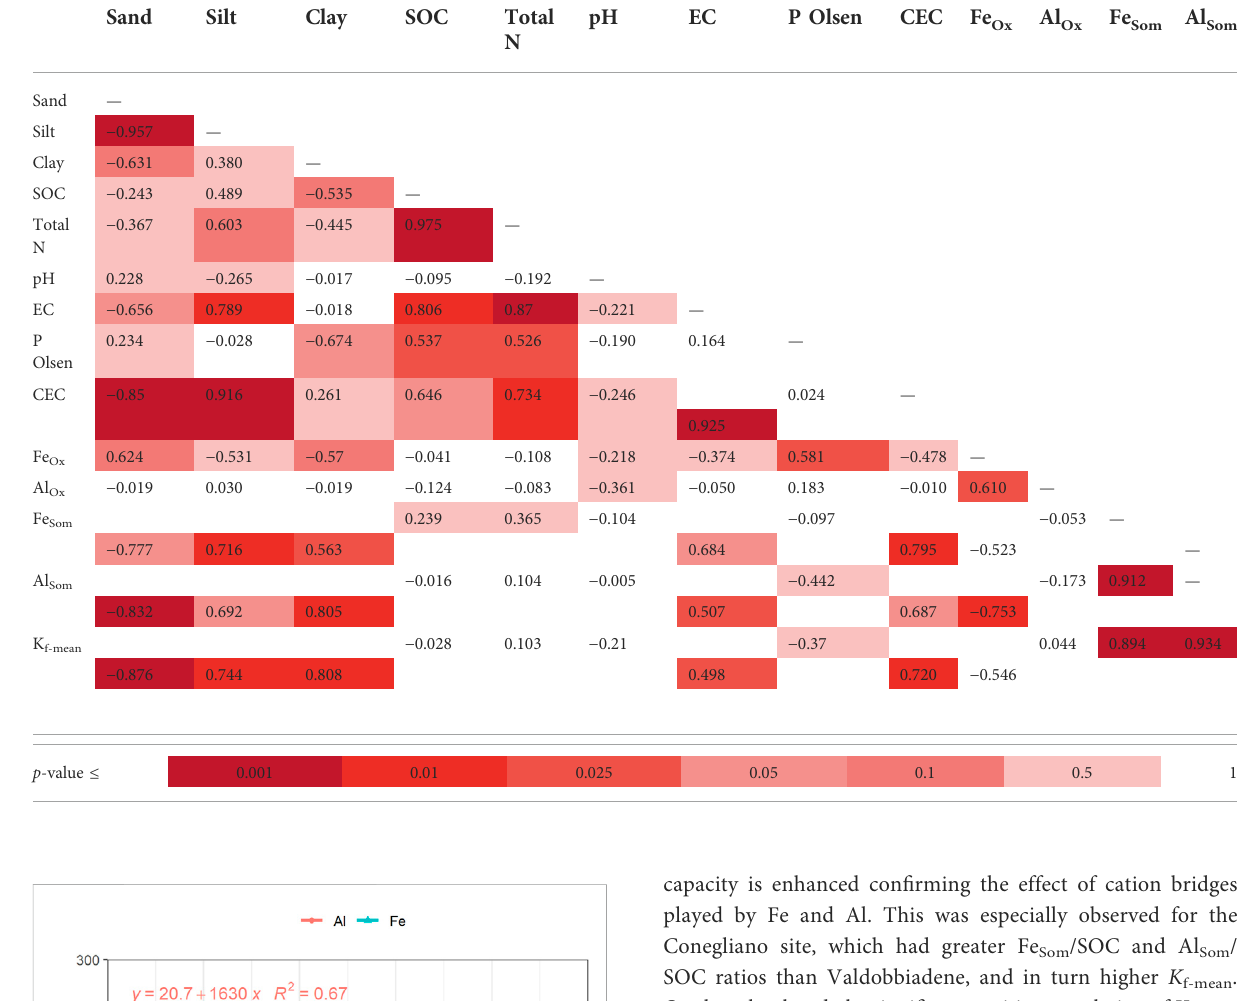
(Table 8) corroborated the GLP af fi nity for fi ne soil particles mainly due to cation bridging (Kah and Brown, 2007).